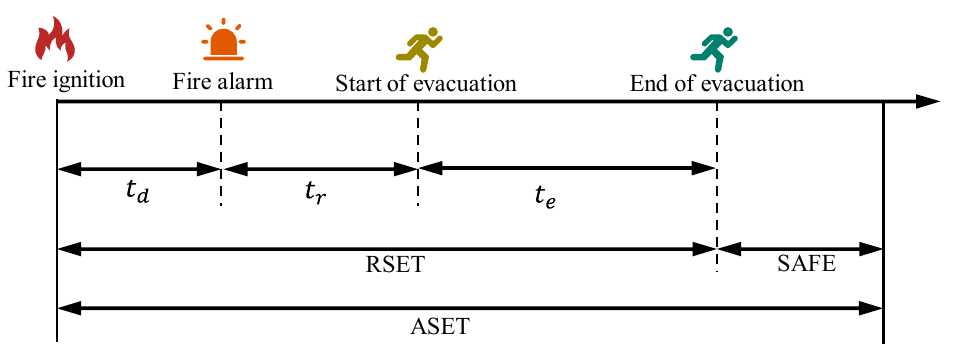
Figure 5. Composition of evacuation time.